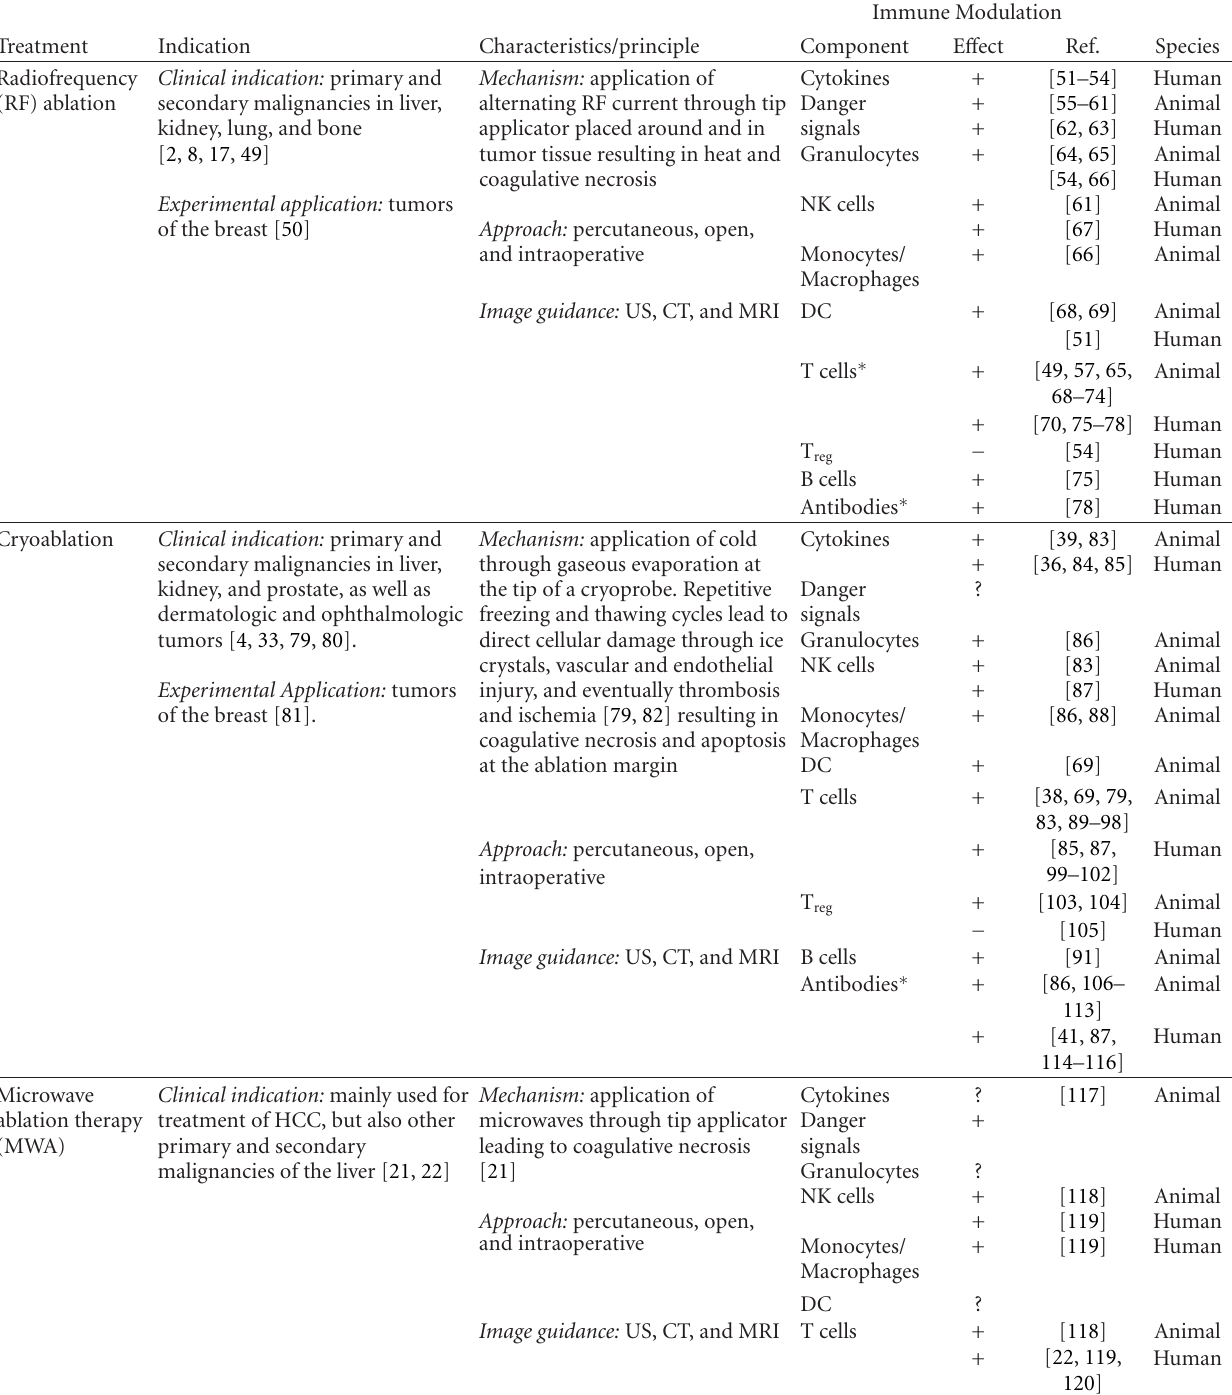
Table 1: Thermal ablative methods in clinical use for the treatment of cancer and described e ff ects on the immune